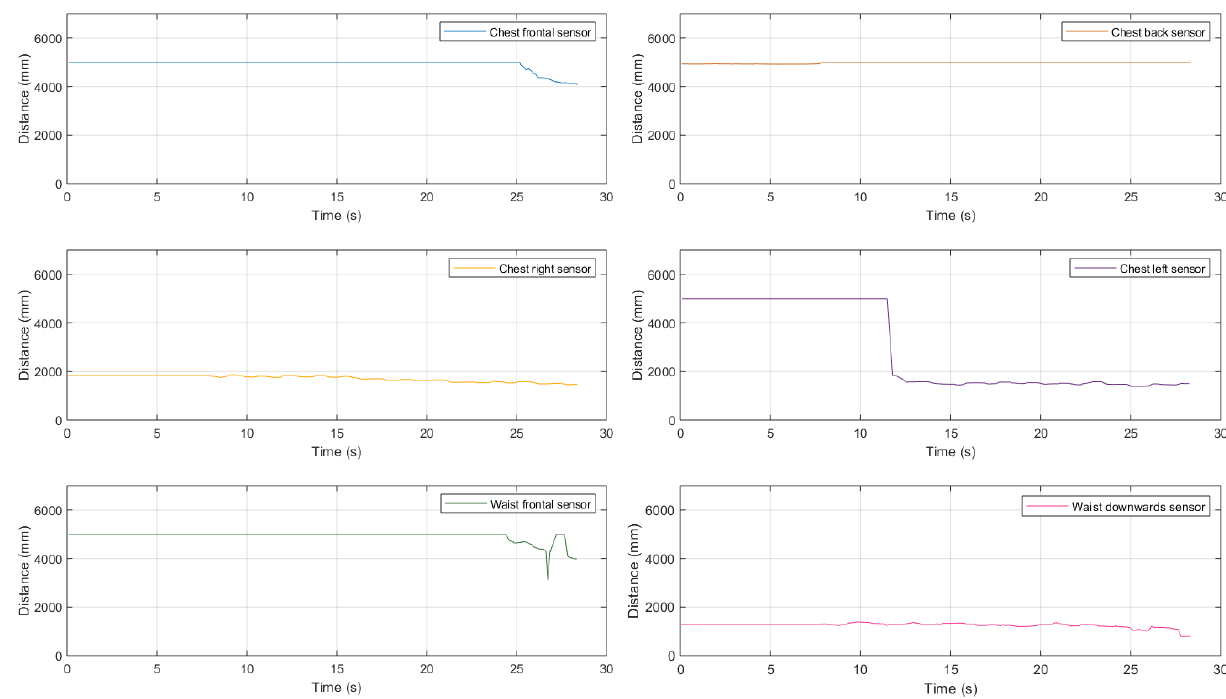
Figure 21. Experimental distance estimates obtained with the configuration shown in Figure 17, in the presence of a 18 × 28 cm small-size obstacle along the